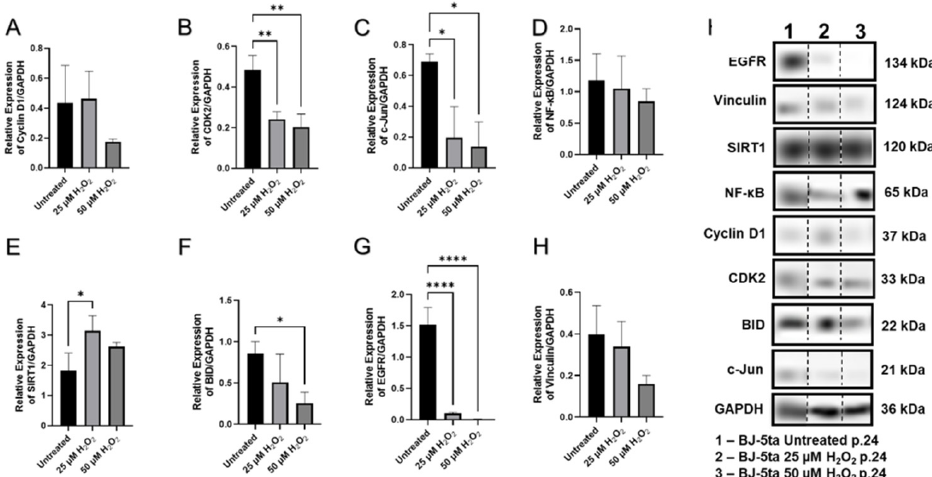
Figure 10. The expression of cell-cycle regulators, functional, and regulatory proteins in aged fibroblasts of BJ-5ta (p.24) cell line. Fibroblasts were aged by the one-step H 2 O 2 senescence model. Figures represents changed protein expression levels for selected genes measured by Western blot. ( A ) Cyclin D1 expression; ( B ) CDK2 expression; ( C ) c-Jun expression; ( D ) NF- κ B expression; ( E ) SIRT1 expression; ( F ) BID expression; ( G ) EGFR expression; ( H ) Vinculin expression. Glyceraldehyde-3-phosphate dehydrogenase (GAPDH) was used as a loading control. Relative densitometry was presented as a ratio of target protein to GAPDH ( I ). Data were analyzed with a one-way ANOVA test (Tukey post-hoc multiple comparison test). Significance (p) is indicated within the figures using the following scale: *, p < 0.05; **, p < 0.01; ****, p < 0.0001. Bars represent mean ± SD. The samples for each protein were run on the same gel (Figures S17–S24). Since the samples were not run consecutively on the same gel, they were spliced for presentation purposes only. No image enhancements were applied.